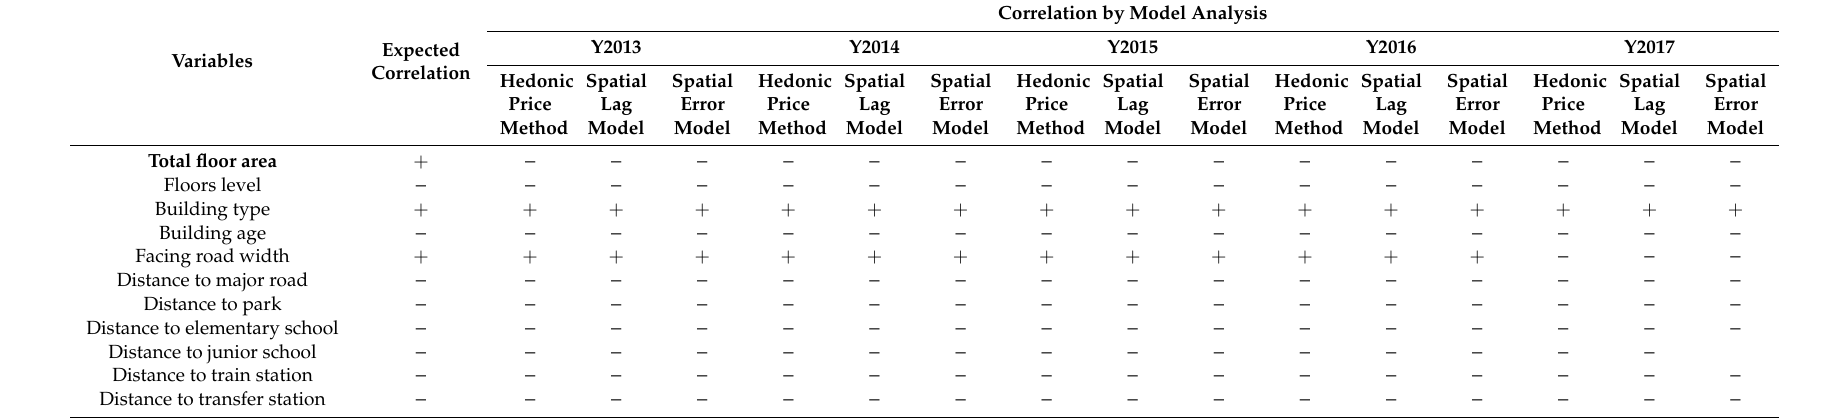
Table 6. Variables correlation and verification of expected correlation and model